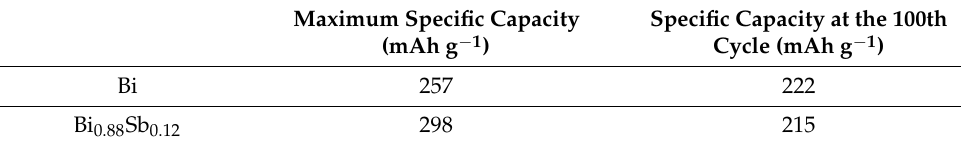
Table 3. Performances of Mg cells assembled with Bi and Bi 0.88 Sb 0.12